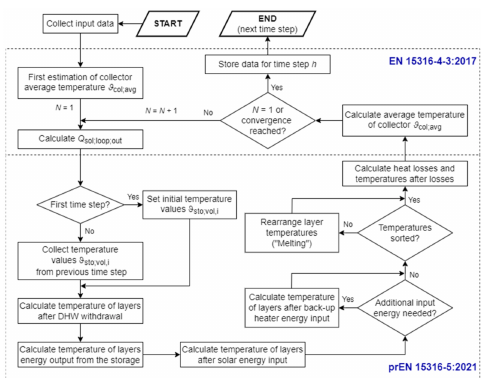
Figure 4. Calculation flowchart of solar collectors and storage tank according to standards EN 15316-4-3:2017 [33] and prEN 15316-5:2021